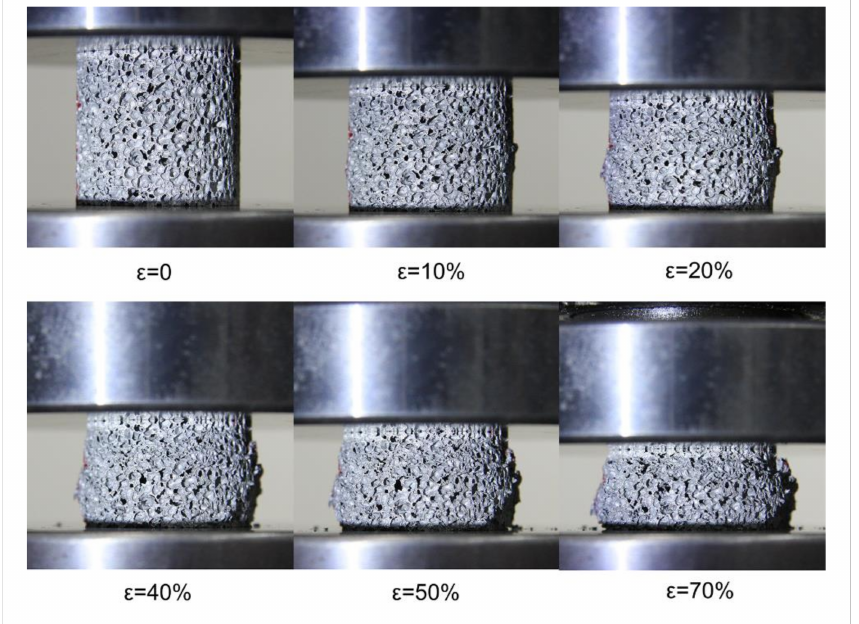
Figure 4. Deformation mode during compression of gradient